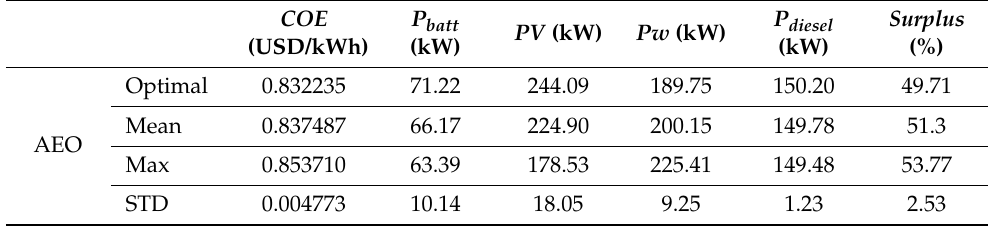
Table 4. Optimal, Minimum, Maximum, and STD for AEO, FSA, and HHO at 80% REF and LPSP of